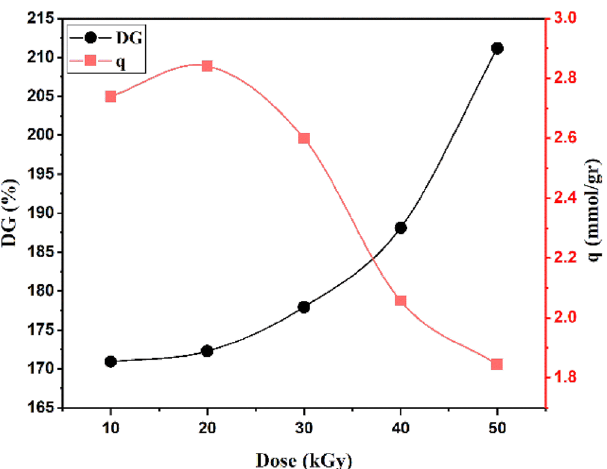
Figure 7. Effect of radiation dose on (DG%) and adsorption capacity